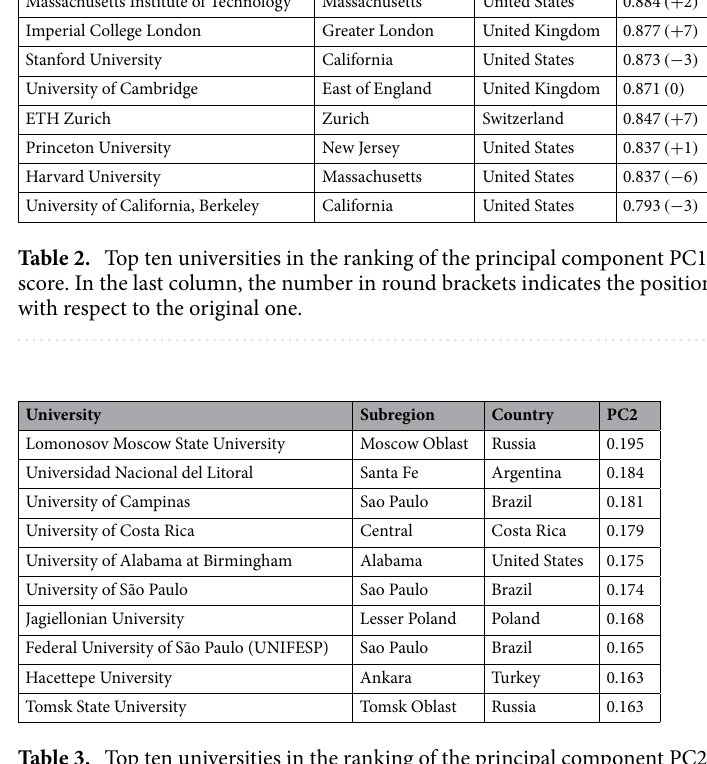
Table 3. Top ten universities in the ranking of the principal component PC2 associated to the THE overall